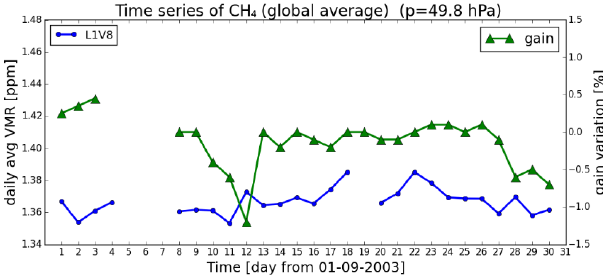
Figure 25. Time series of CH 4 global average at pressure 49.8hPa relative to September 2003 derived from L2 V8 MIPAS data (blue line) and the used gain function (green line), with the triangles indi- cating the days at which the gain function has been